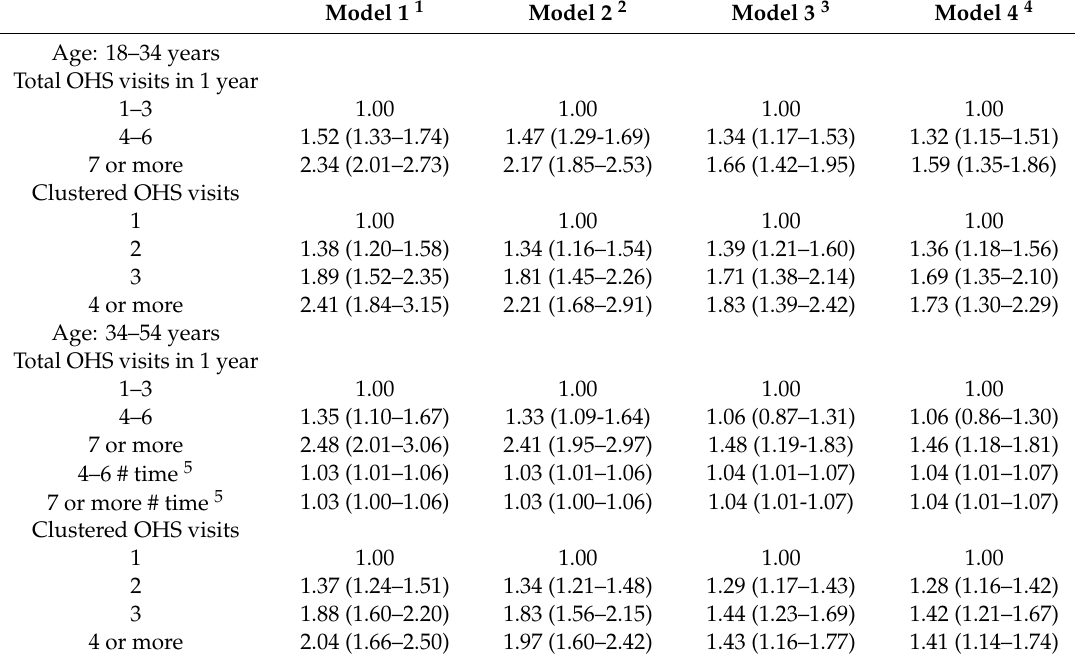
Table 2. Sickness absence due to mental disorders among the employees of the City of Helsinki by age group and OHS utilization, hazard ratios (HRs; 95%